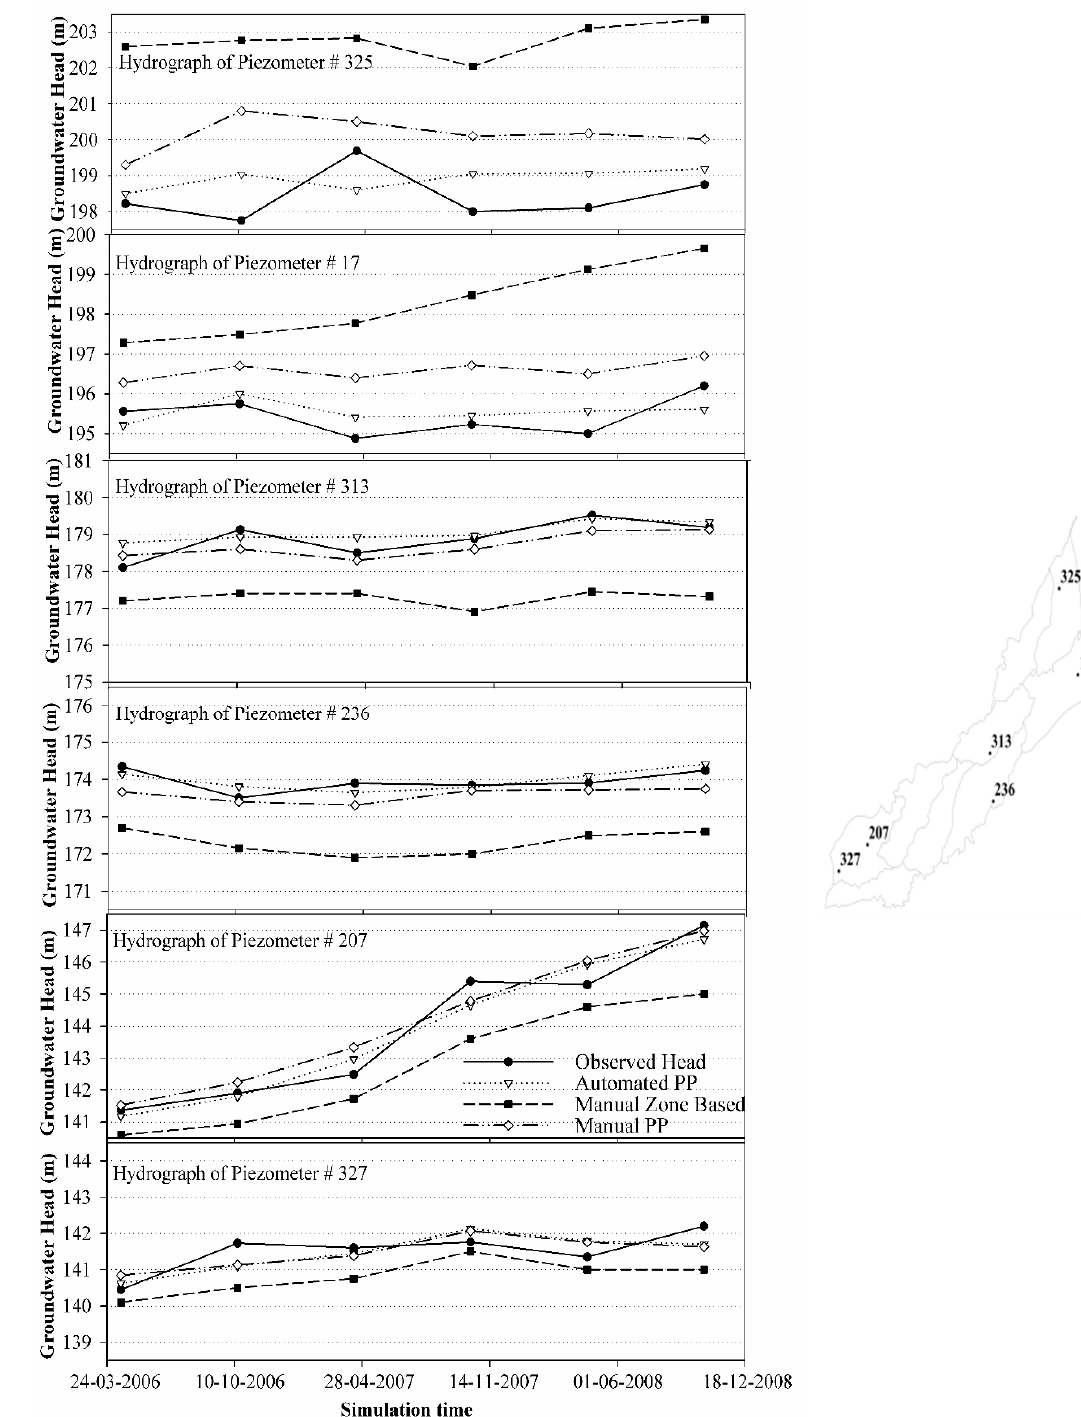
Figure 9. Hydrographs of selected piezometers at different model locations for comparison of different calibration methods along with observed heads.